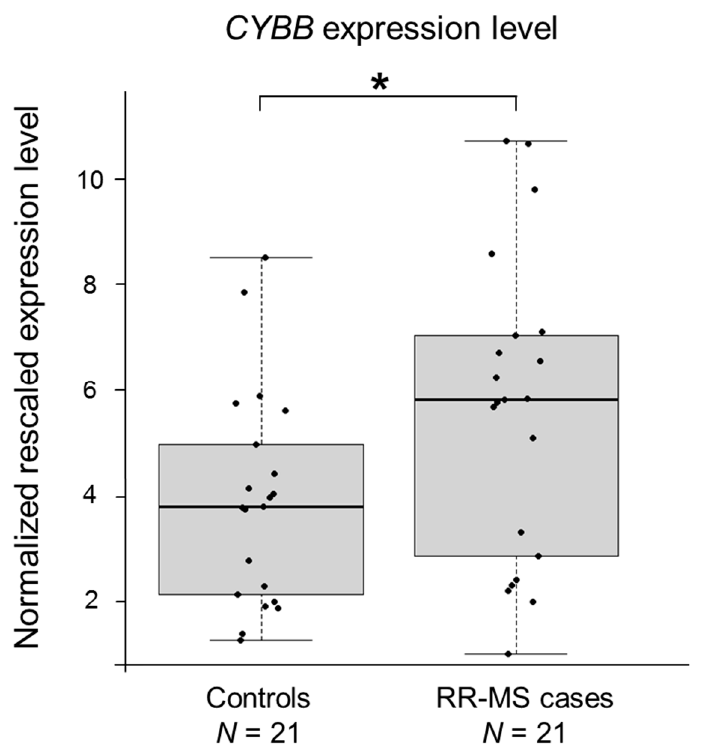
Figure 3. CYBB is upregulated in MS patients. Boxplots show the expression levels of the CYBB gene measured by semi-quantitative real-time RT-PCR in PBMCs of an Italian case-control cohort (only female individuals). Boxes define the interquartile range; the thick line refers to the median. Results were normalized to expression levels of the HMBS and ACTB housekeeping genes and are presented as rescaled values. The number of subjects belonging to each group is indicated ( N ). Significance levels of t -tests are shown. *: p < 0.05.